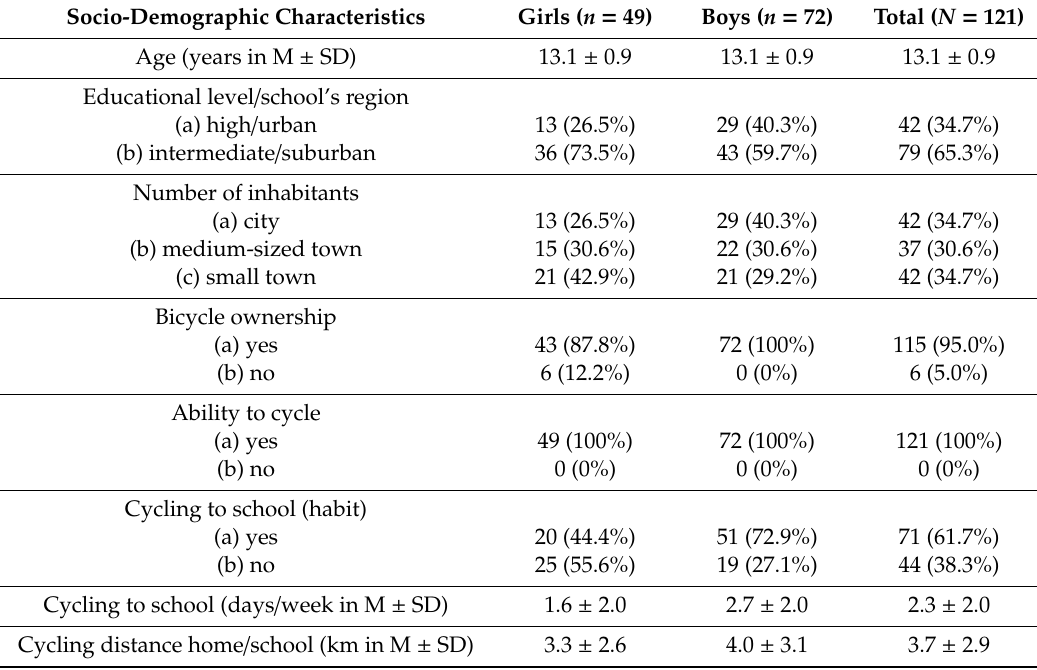
Table A1. Socio-Demographic Characteristics based on the Sample of Students.